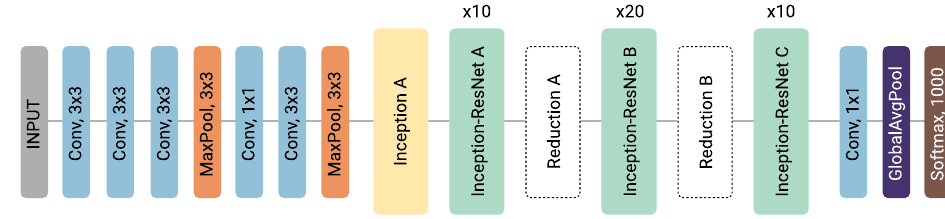
Figure 9. Inception-ResNetV2